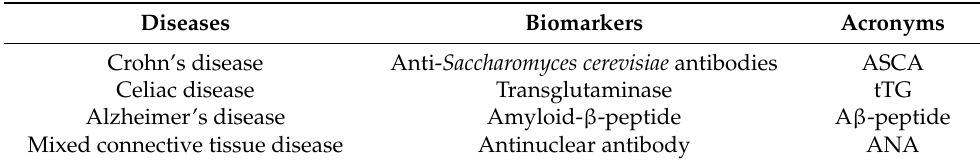
Table 1. Diseases, corresponding biomarkers, and acronyms. Diseases Biomarkers Acronyms Crohn’s disease Anti- Saccharomyces cerevisiae antibodies ASCA Celiac disease Transglutaminase tTG Alzheimer’s disease Amyloid- β -peptide A β -peptide Mixed connective tissue disease Antinuclear antibody